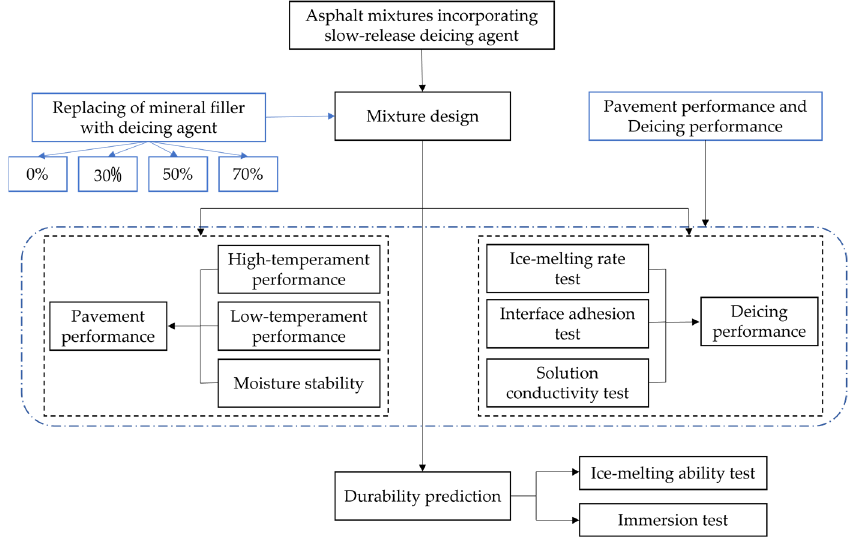
Figure 1. Experimental work flowchart.